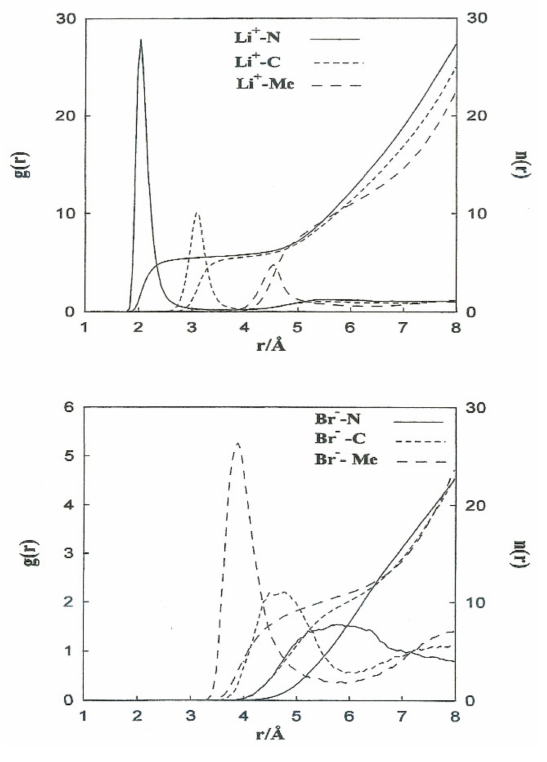
distribution functions and running coordination numbers for Li + (top) and Br −